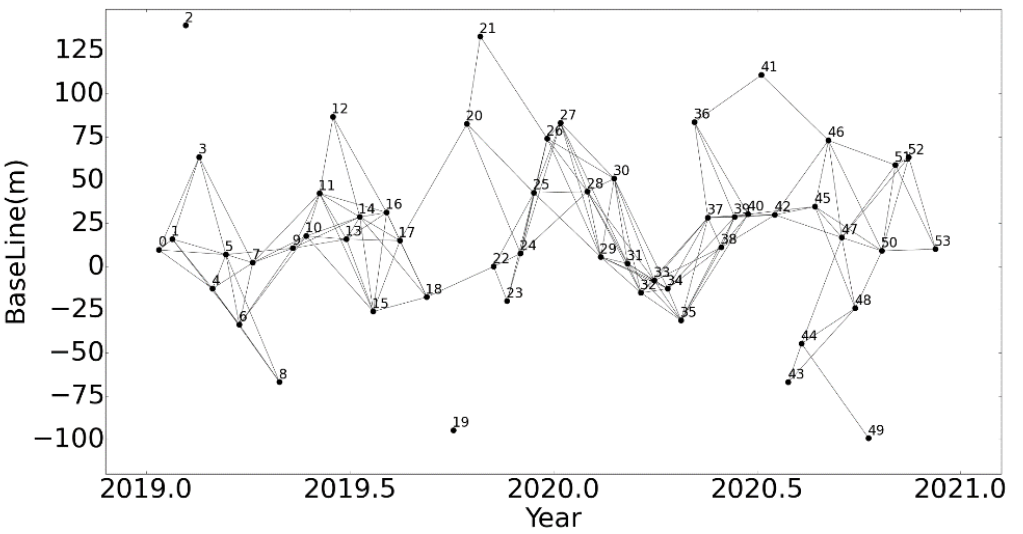
Figure 3. The baseline map of Sentinel-1 images.